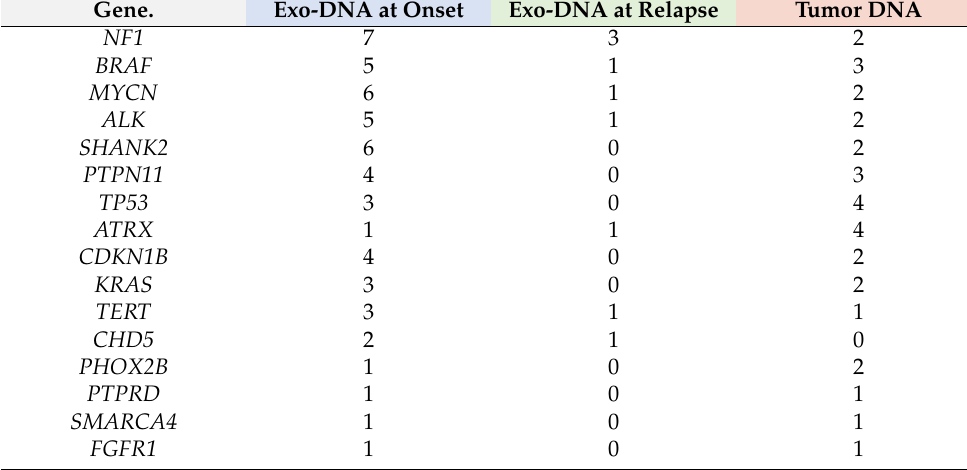
Table 6. Genes displaying copy number variations (CNVs) in exo-DNA and in tumor DNA.